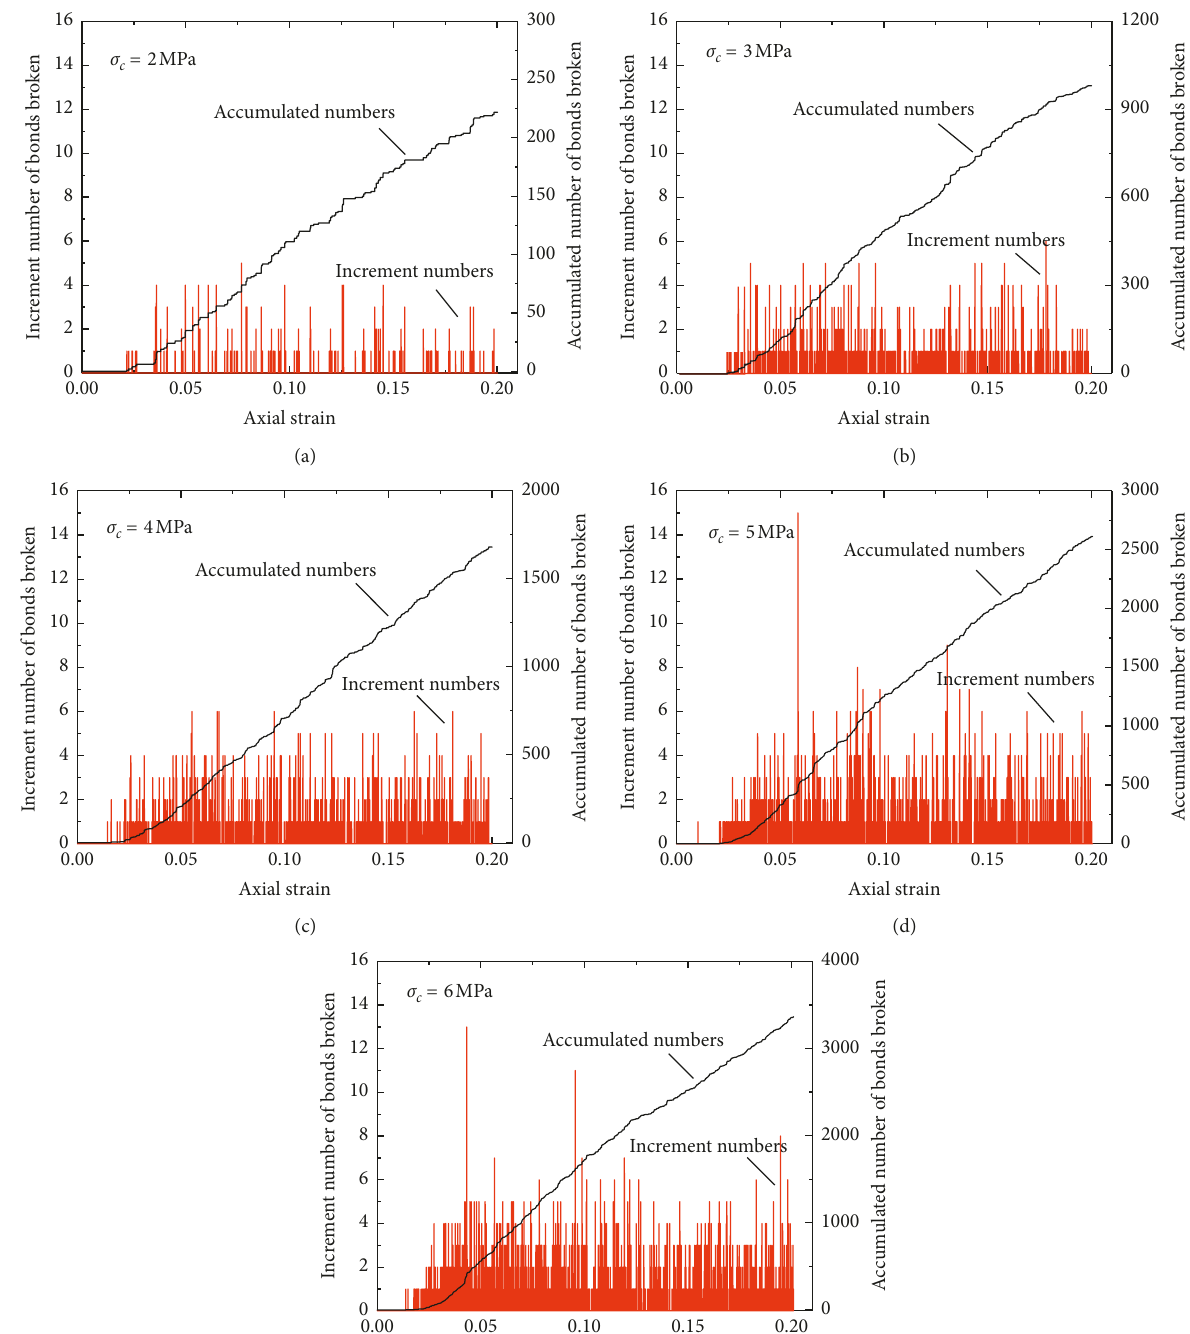
Figure 17: Evolution of bond breakage: (a) σ